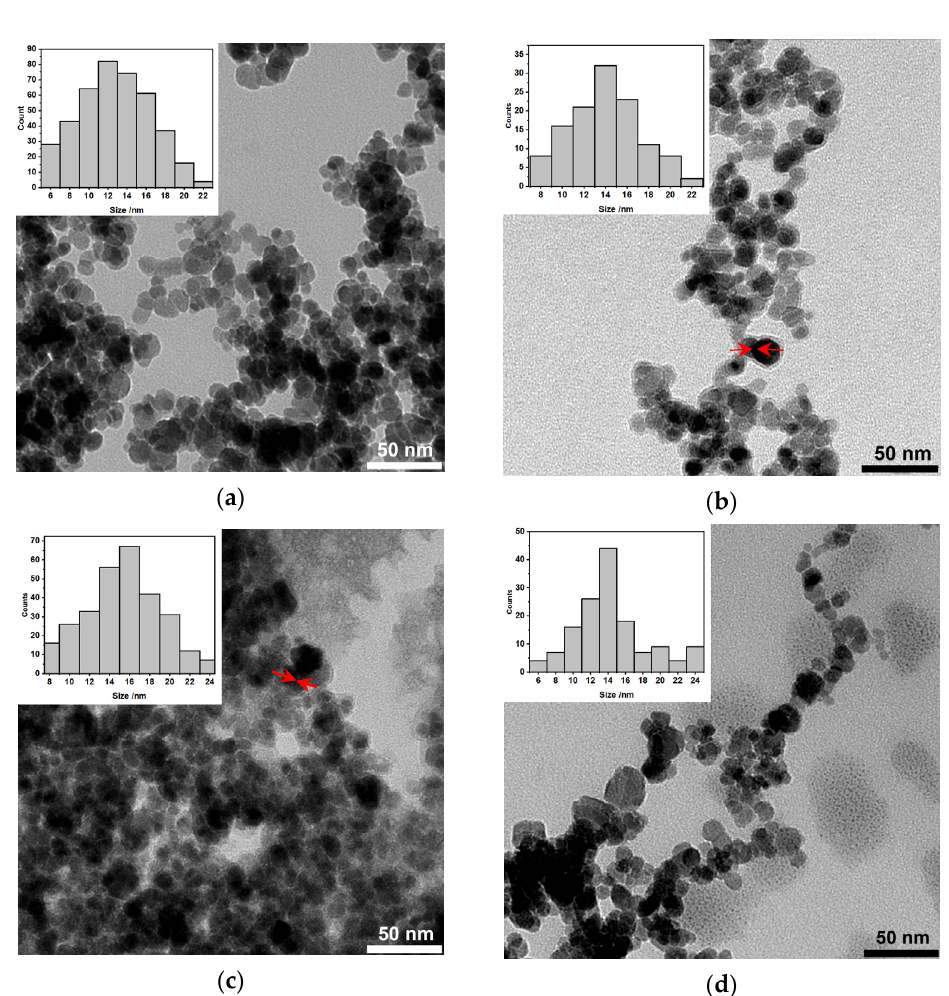
Figure 4. Transmission Electron Microscopy images of NPs: ( a ) Citrate stabilized [Ho]Fe 3 O 4 @CA and [Ho]Fe 3 O 4 @Au; ( b ) [Ho]Fe 3 O 4 @Au coated with PEG linker, before the attachment of Tmab; ( c ) [Ho]Fe 3 O 4 @Au-Tmab radiobioconjugates (PEG linker presence is not mentioned for clarity); and ( d ) [Ho]Fe 3 O 4 @Au-Tmab bioconjugates after magnetic hyperthermia treatment. Red arrows ( b , c ) point to the PEG or PEG-Tmab “misty” corona surrounding the [Ho]Fe 3 O 4 @Au core. Table 1. Values of hydrodynamic diameter and zeta potential of nanoparticles measured in PBS.